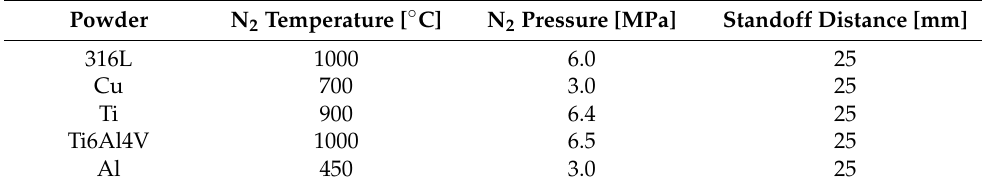
Figure 4. Feedstock particle size distribution for CSAM.